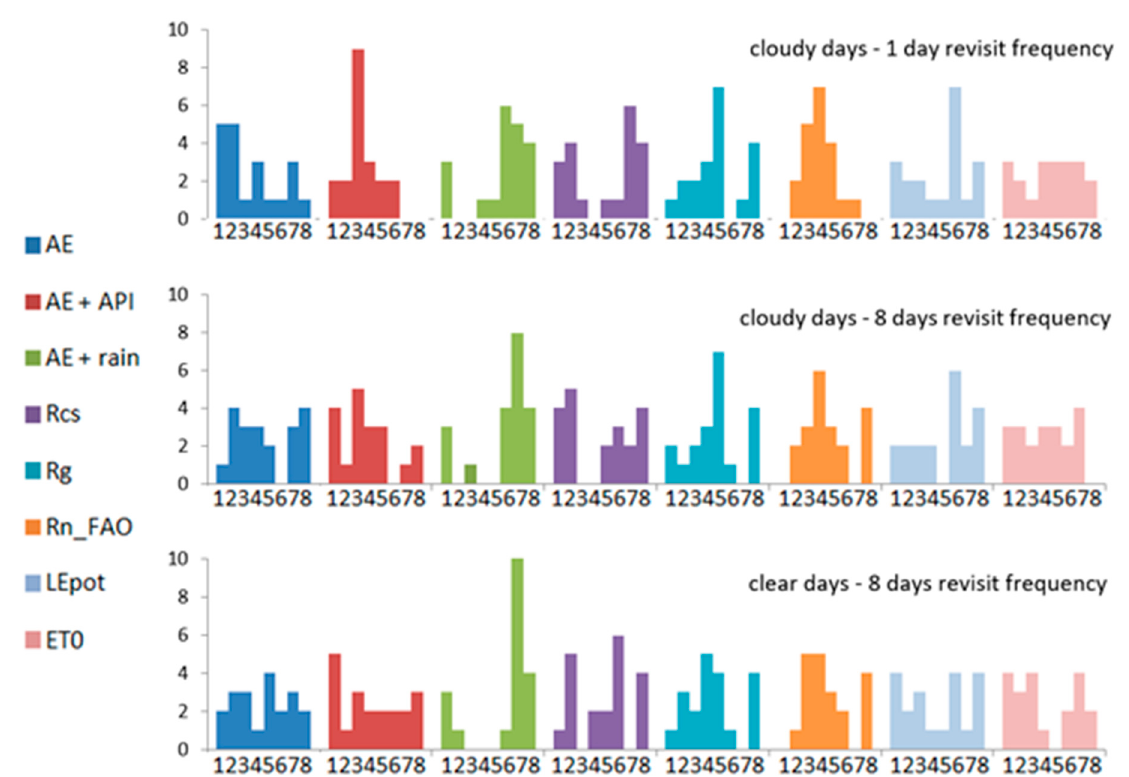
Figure 4. Number of performance rank occurrences of each reference quantity for cloudy days for 1 day revisit frequency (upper panel), for cloudy days and clear days for an 8-day revisit (middle and bottom panel, respectively).